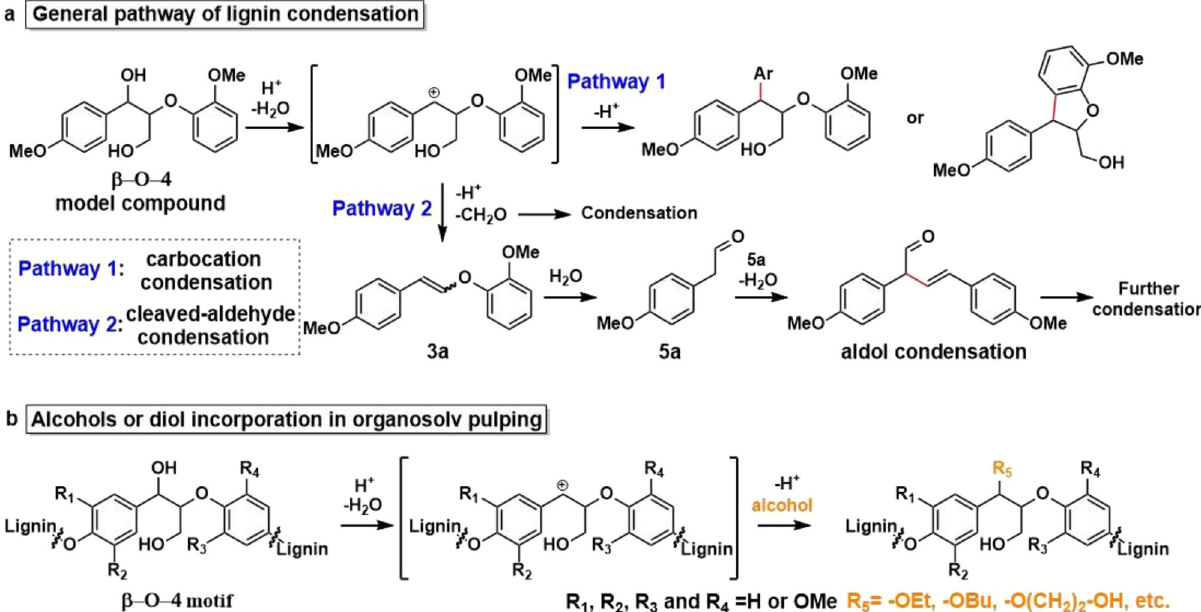
Fig. 2 Reaction pathways in lignin acidolysis. a Recondensation pathways in acidolysis demonstrated on a model compound comprising the β -O-4 moiety. These involve rapid dehydration and direct capture of the formed carbocation species, by a neighboring aromatic lignin moiety or by intramolecular condensation to result in recalcitrant C – C linkages 37 – 39 . Alternatively, depolymerization occurs via a series of steps involving the vinyl ether intermediate 3a which suffers rehydration and cleavage to furnish a free phenol and the corresponding C2 aldehyde 5a (see also Supplementary Fig. 4). b Incorporation of alcohols or diols into lignin during the acid-catalyzed organosolv pulping